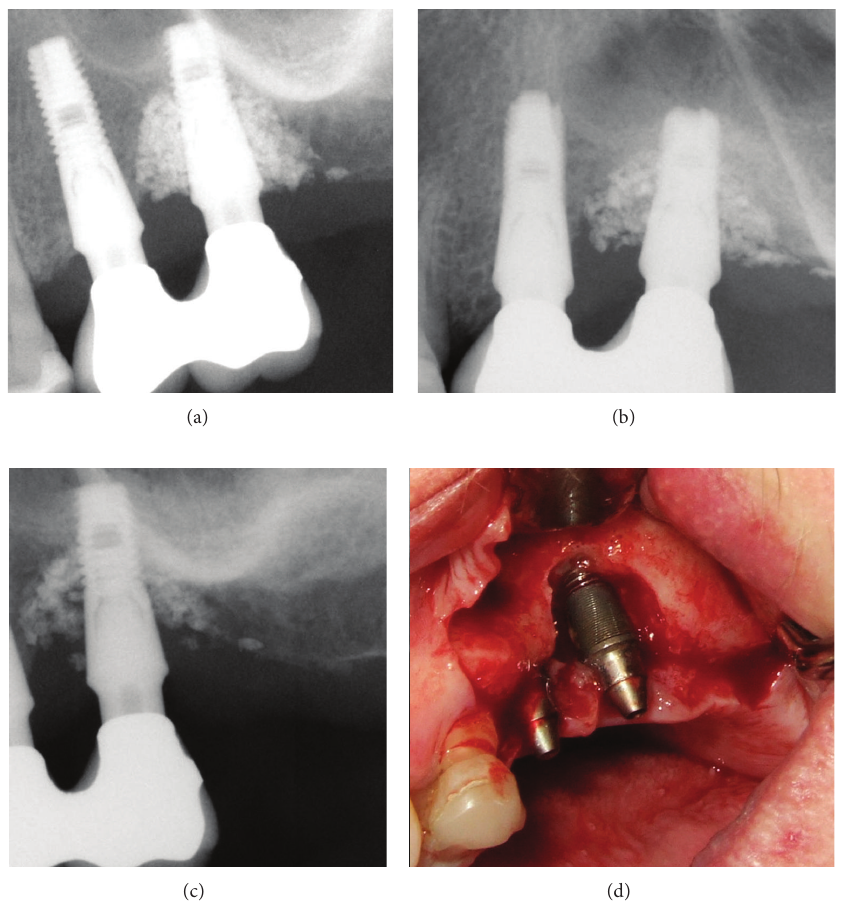
Figure 6: Illustration of sequence of radiological followup and clinical baseline status of patient number 3. Note the marked loss of grafting material in the defect (narrow crest). Extensive filling of defect with PTG at surgery resulted in loss of grafting material but with a gingival level that accordingly was positioned more apically without signs of marked inflammation or